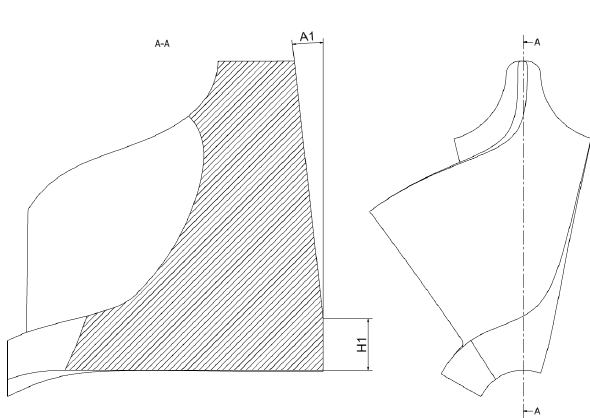
Five methods were considered. Below is a short de- scription of each one of them.